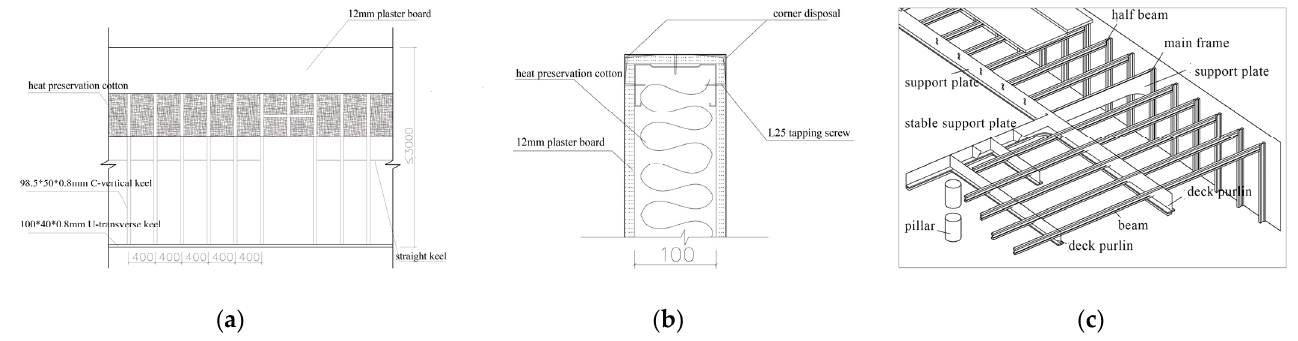
Figure 4. Bulkhead and deck construction. ( a ) Bulkhead construction, ( b ) Bulkhead profiles, ( c ) Deck construction.